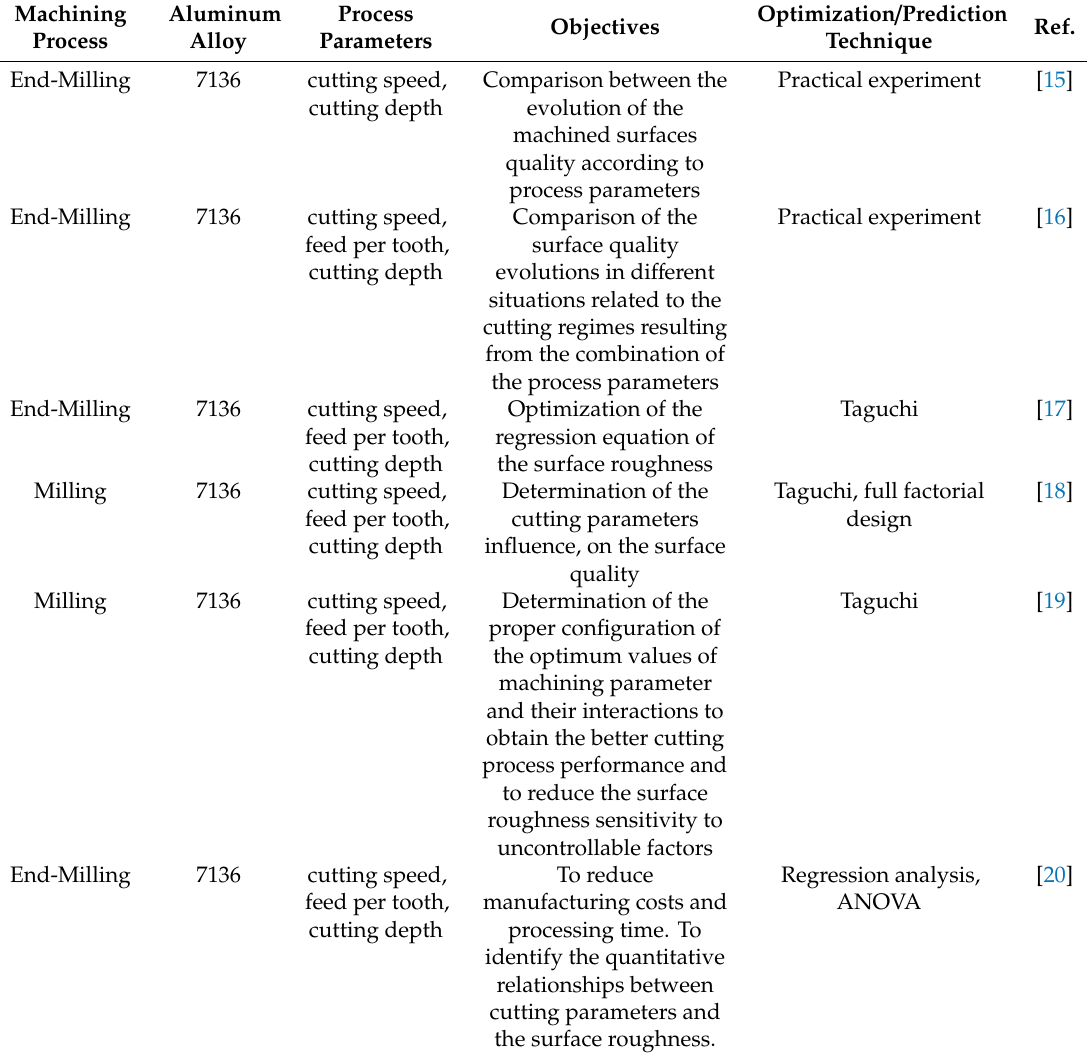
Table 1. Identified research on Al7136